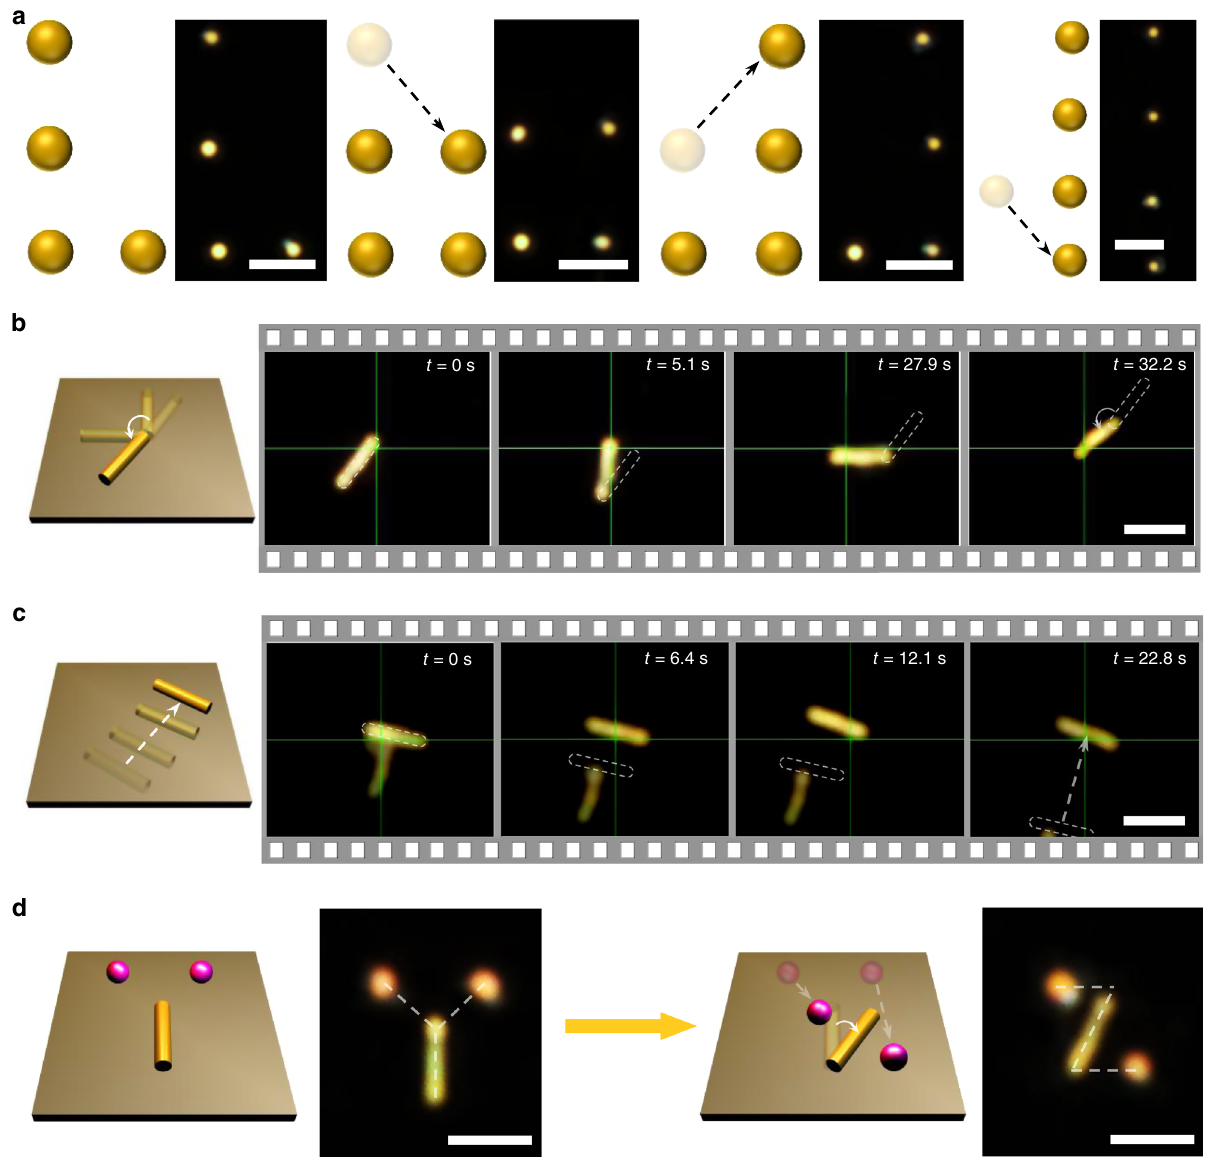
Fig. 4 Recon fi gurable patterning of particles and nanowires. a Recon fi gurable patterning of four 300 nm AuNPs. Four particles were arranged into L-shape, a square, mirrored L-shape, and a straight line, sequentially. The dashed arrows show the recon fi gurable patterning sequence. b , c Schematic illustrations and successive optical images showing the real-time ( b ) rotation and ( c ) translation of AuNWs. The green crosshairs mark the positions of the laser beam. The dashed rectangular outline indicates the original positions of nanowires. d Schematic illustration and optical images showing recon fi gurable patterning of metal-dielectric hybrid nanostructures. Two 500 nm SiNPs and one AuNW were patterned into “ Y ” and “ Z ” , sequentially. Scale bars: a , 5 μ m; b – d 3 μ